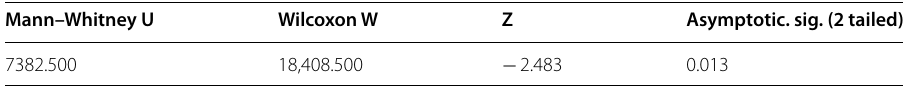
Table 8 Spearman’s rho correlation, Grit, CE, and WTC for the public school students and private institute learners